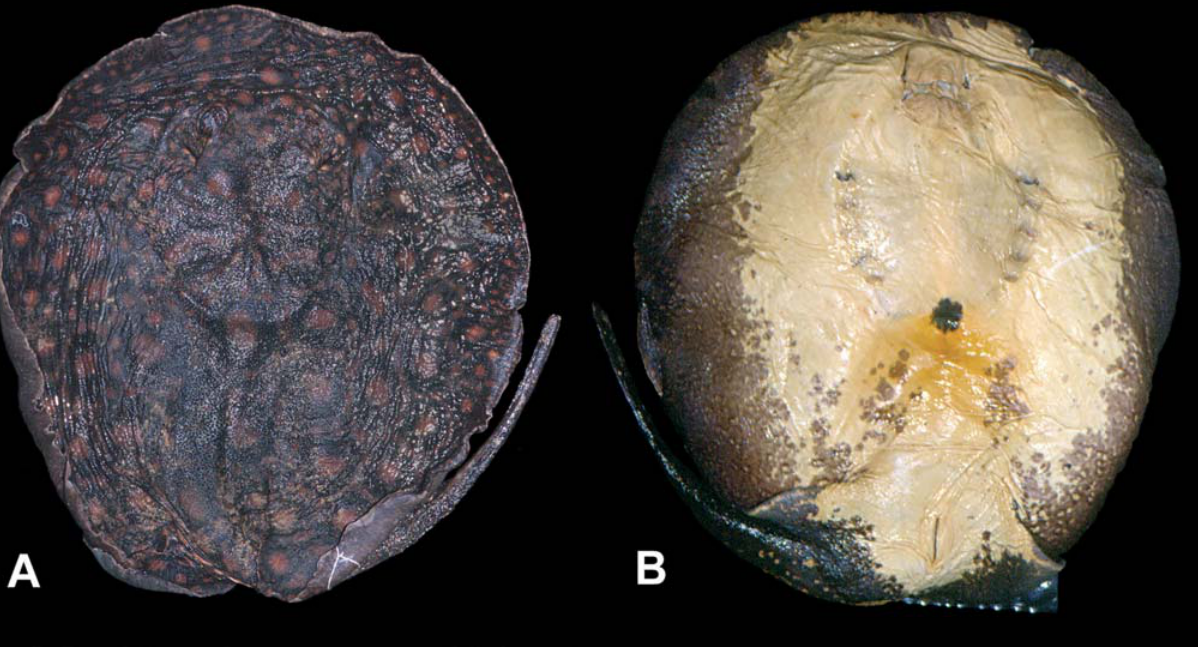
Fig. 5. Potamotrygon boesemani . Dorsal ( A ) and ventral ( B ) views of paratype (USNM 388849, female, 427 mm DW), from Corantijn